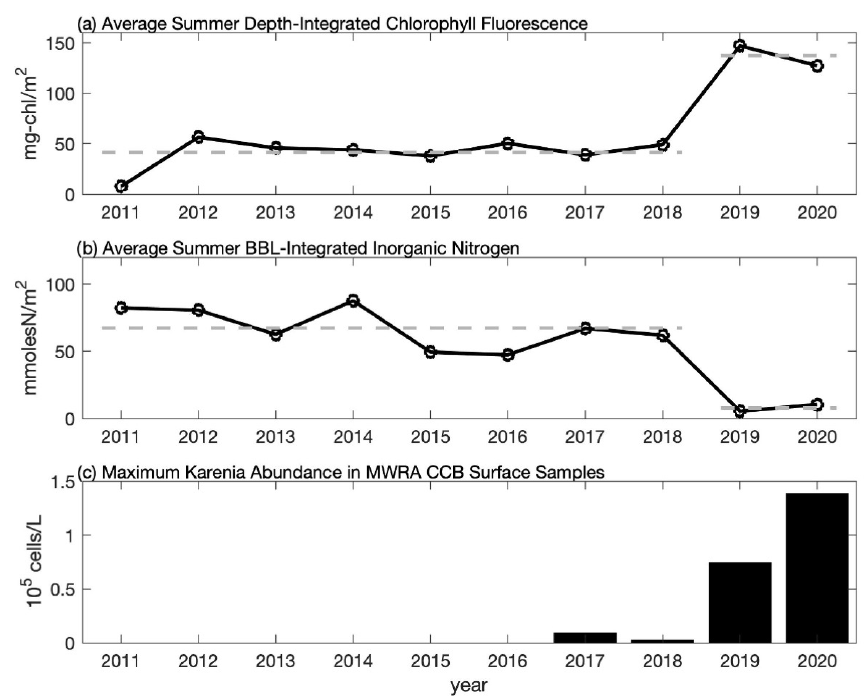
Figure 6. Time series of the average summer (a) depth-integrated chlorophyll fluorescence from CCS surveys, (b) bottom boundary layer (BBL) integrated inorganic nitrogen from CCS surveys, and (c) maximum abundance of K. mikimotoi from MWRA late-summer (August and September) surface samples in CCB (F01 and F02). In (a) and (b) each point represents the average over the August and September CCS cruises and over all eight CCB stations. Average values for 2011–2018 and 2019–2020 are shown with the thick dashed line highlighting that the 2019–2020 data differ by more than a factor of 3 from the 2011–2018 average. In (c) , maximum abundance is based on the highest value reported during late summer at either F01 or F02 (see Table S1 for